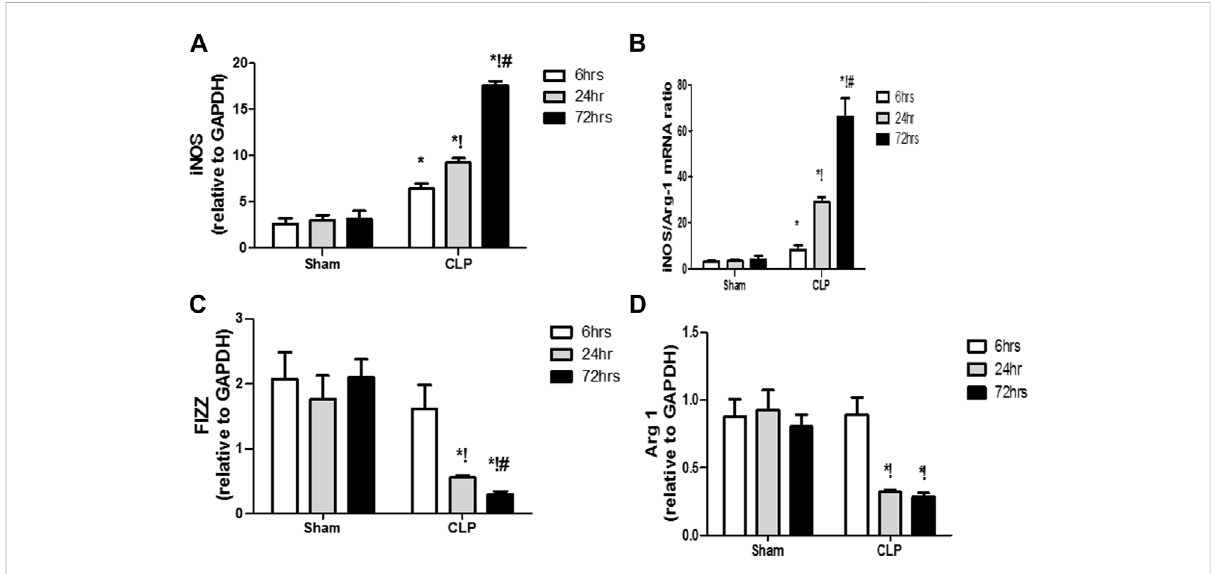
FIGURE 6 Changes in macrophage polarization over time in sepsis-induced encephalopathy. (A – D) Quantitative real-time reverse-transcription polymerase chain reaction analysis of macrophage polarization biomarkers: M1 pro-in fl ammatory macrophage iNOS (A) and M2 anti-in fl ammatory macrophage iNOS/Arg-1 ratio (B) , FIZZ1 (C) , and Arg-1 (D) . All expression levels were normalized to that of GAPDH. Data are the means ± SEM. * p < 0.05 vs. the corresponding sham group; ! p < 0.05 vs. the 6 h CLP group; # p < 0.05 vs. the 24 h CLP group. N = 10 rats per